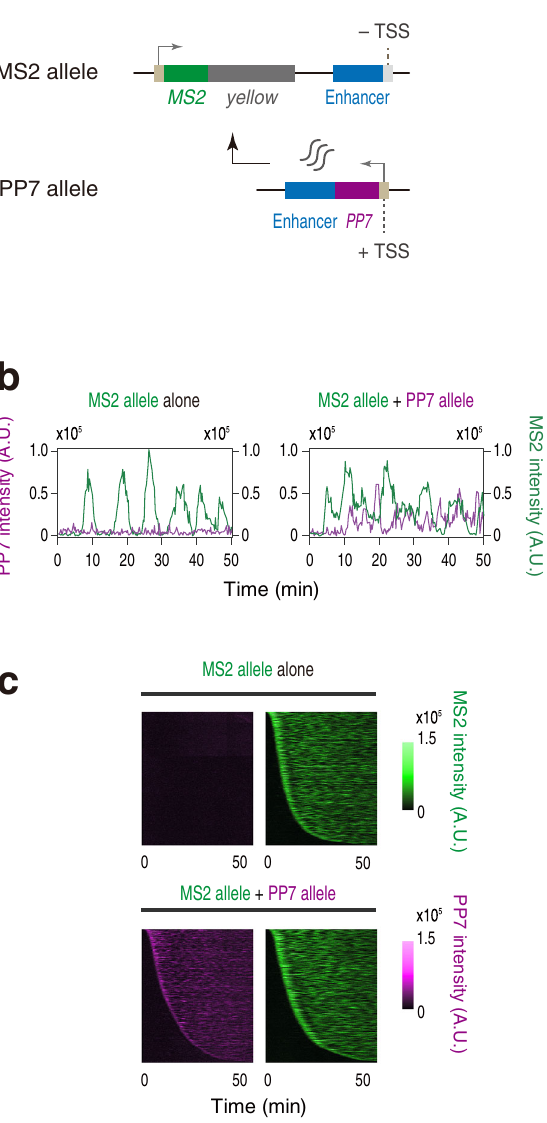
median. Whiskers extend to the most extreme, non-outlier data points. e Histograms showing the distribution of MS2 burst frequency. f Boxplot showing the distribution of MS2 burst size. The box indicates the lower (25%) and upper (75%)quantileandthewhitelineindicatesthemedian.Whiskersextendtothemost extreme,non-outlierdatapoints.Atotalof4917and4109MS2bursts,respectively, were analyzed for embryos lacking or containing the PP7 allele. The double hash mark on the y-axis indicates that >99% of the data points are presented. g Boxplot showingthedistributionofthetotaloutputofMS2transcription.Theboxindicates the lower (25%) and upper (75%) quantile and the white line indicates the median. Whiskers extend to the most extreme, non-outlier data points. A.U.; arbitrary unit. Percentages shown at the bottom of boxplots represent the relative values of the median. P values were calculated by a two-sided Wilcoxon rank-sum test. Source data are provided as a Source Data fi